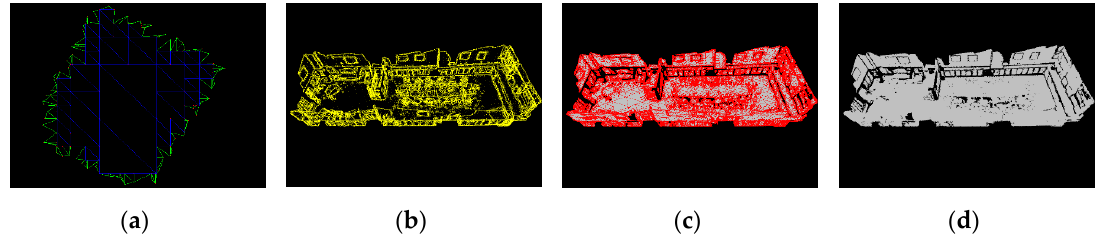
Figure 11. Feature triangulation: ( a ) triangulation of one planar point cloud, ( b ) all preserved vertices of triangulation, ( c ) the adjacency of the triangulation, and ( d ) the mesh model.